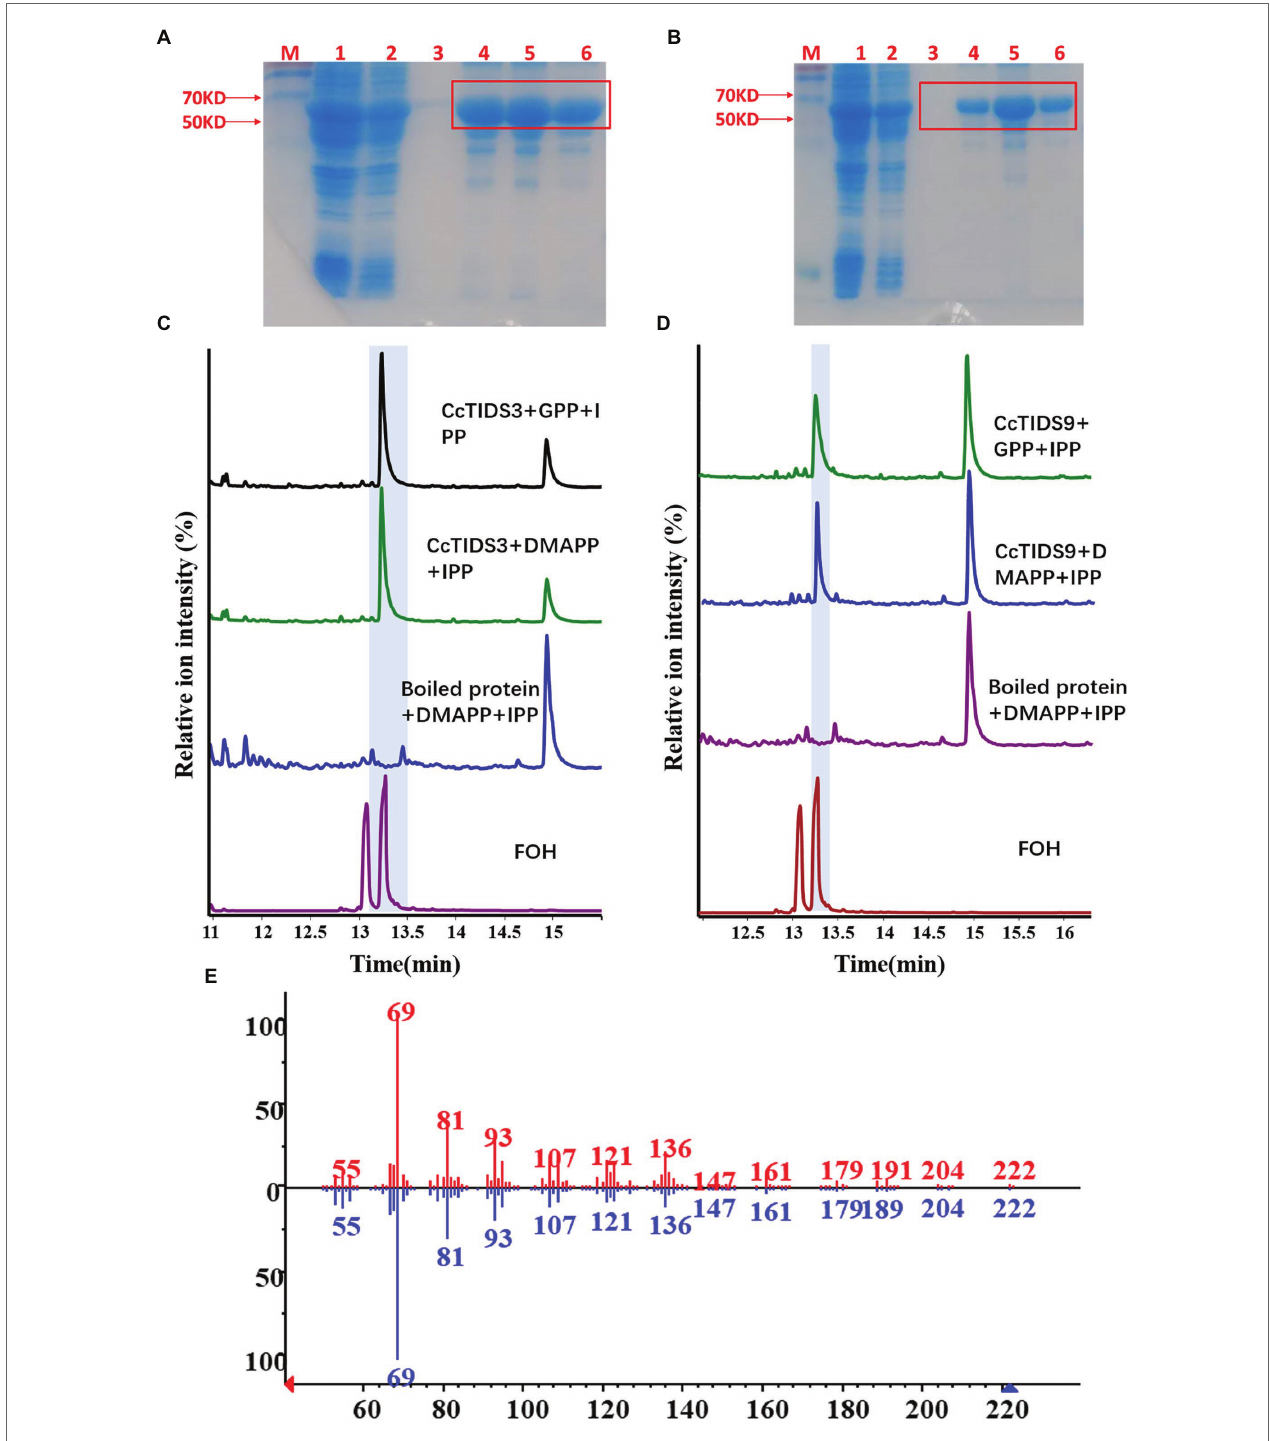
FIGURE 7 | Gas chromatography–mass spectrometry (GC–MS) profile showing in vitro reaction products of C. camphora trans-prenyltransferases CcTIDS3 and CcTIDS9, where different prenyldiphosphates were used as substrates. Expression and purification of (A) CcTIDS3 and (B) CcTIDS9 recombinant protein from Escherichia coli Rosetta (DE3) harboring pET32a(+)–CcTIDS3/CcTIDS9, where lane 1 shows the total protein after induction, 2 shows the soluble protein, and 3–6 shows the purified CcTIDS3 or CcTIDS9 recombinant protein from the first to the fourth collected tube. The GC–MS chromatogram of the reaction products generated by (C) CcTIDS3 and (D) CcTIDS9 and the acid hydrolysis products of farnesol (FOH) standards. (E) Mass spectra of farnesol standard (shown in red) and products in the NIST14/Wiley275 library (blue). GPP, geranyl diphosphate; DMAPP, dimethylallyl diphosphate; and IPP, isopentenyl